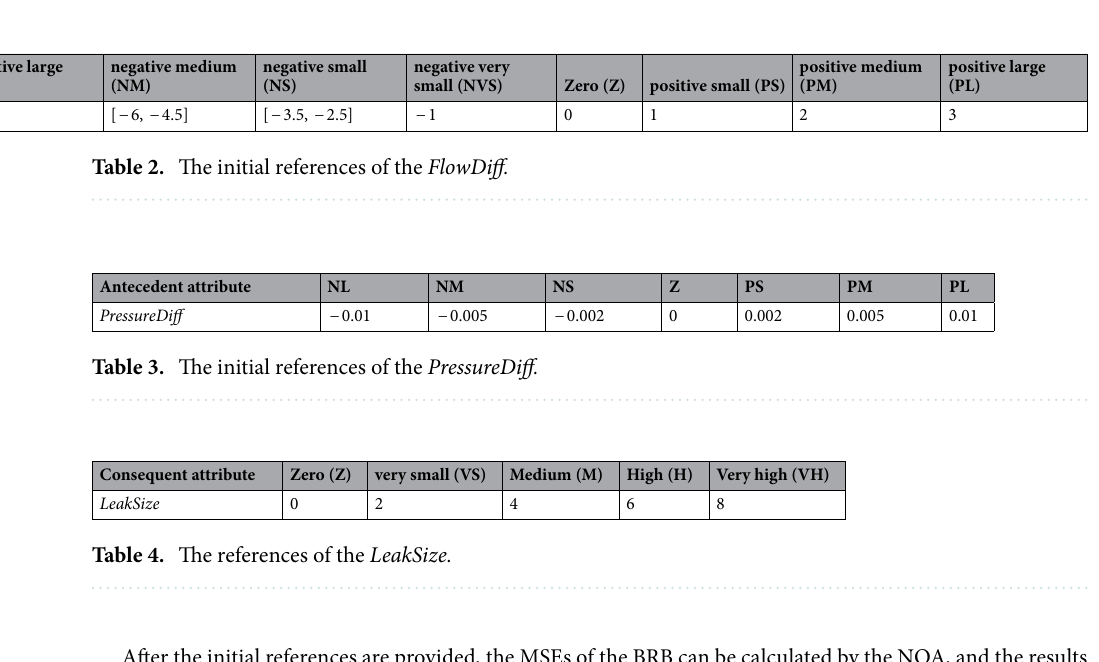
Figure 3. Calculated FlowDiff and PressureDiff of the samples.